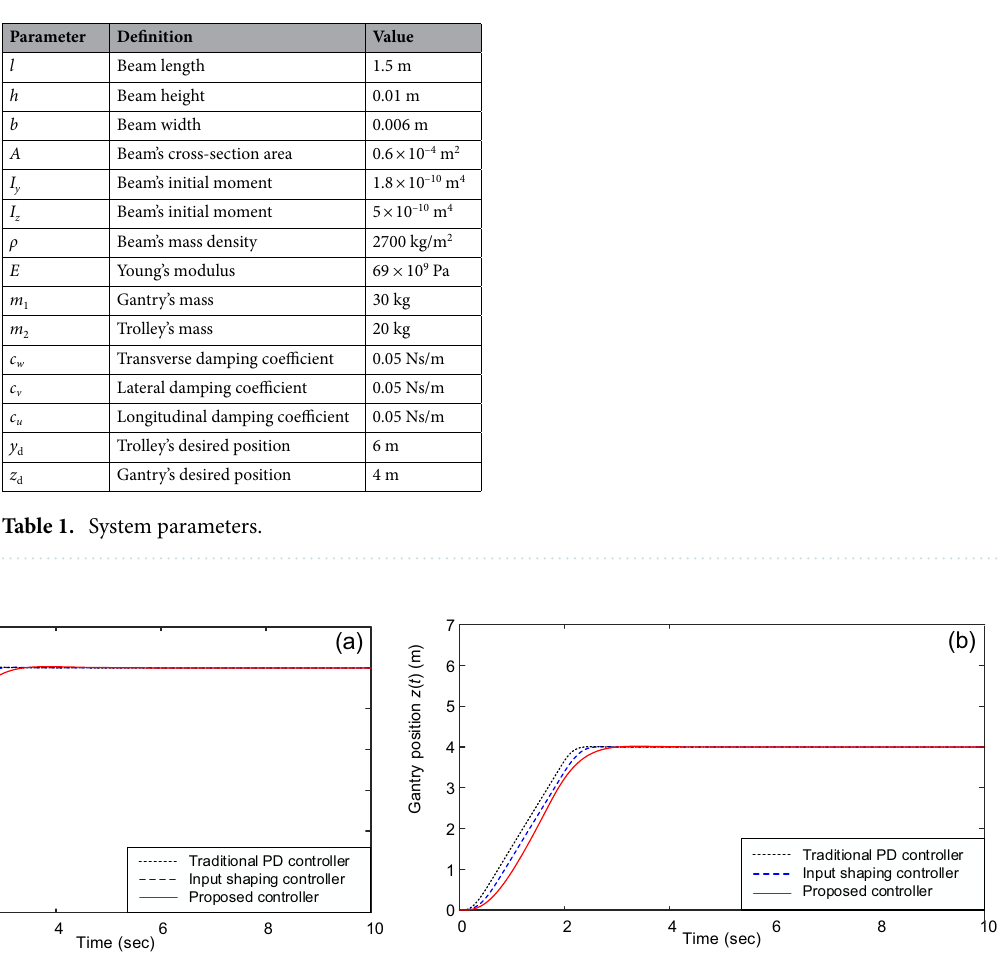
Figure 2. ( a ) Trolley’s position and ( b ) gantry’s